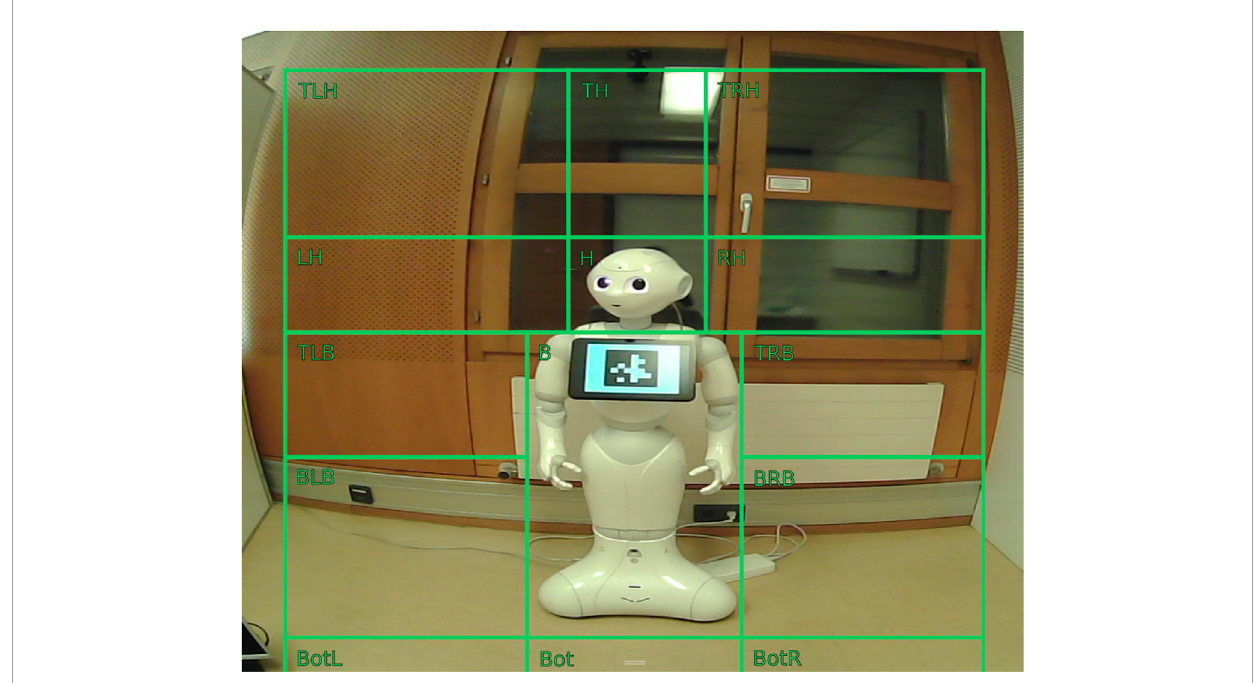
FIGURE 3 Regions of interest (ROI) relative to the Pepper robot as seen from the world view camera of the eye-tracking device from top left to bottom right: top left head (TLH), top head (TH), top right head (TRH), left head (LH), head (H), right head (RH), top left body (TLB), body (B), top right body (TRB), bottom left body (BLB), bottom right body (BRB), bottom left (BotL), bottom (Bot), and bottom right (BotR).